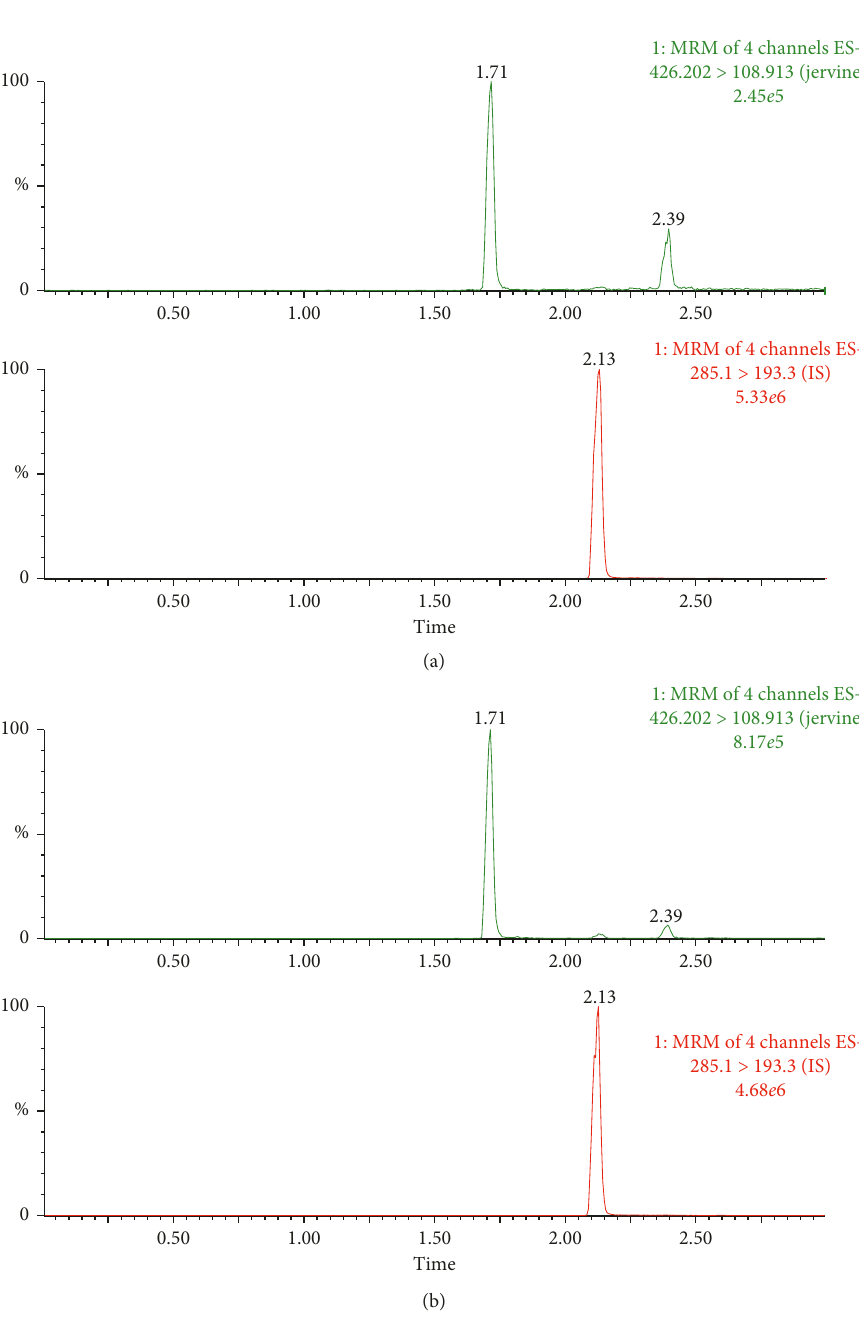
Figure 2: UPLC-MS/MS of jervine and diazepam in rat plasma. (a) The blank plasma spiked with jervine and diazepam and (b) the plasma samples after intravenous administration of jervine.